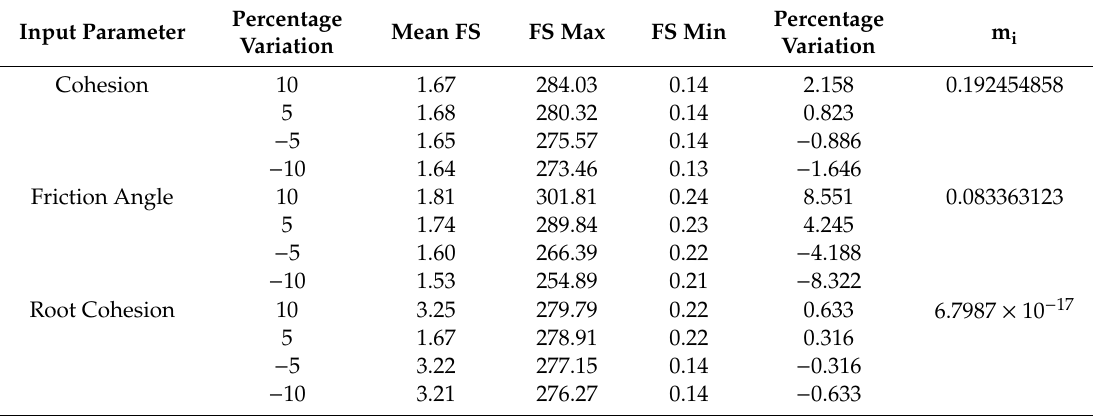
Table 5. Results of the simulations performed for different input parameters.